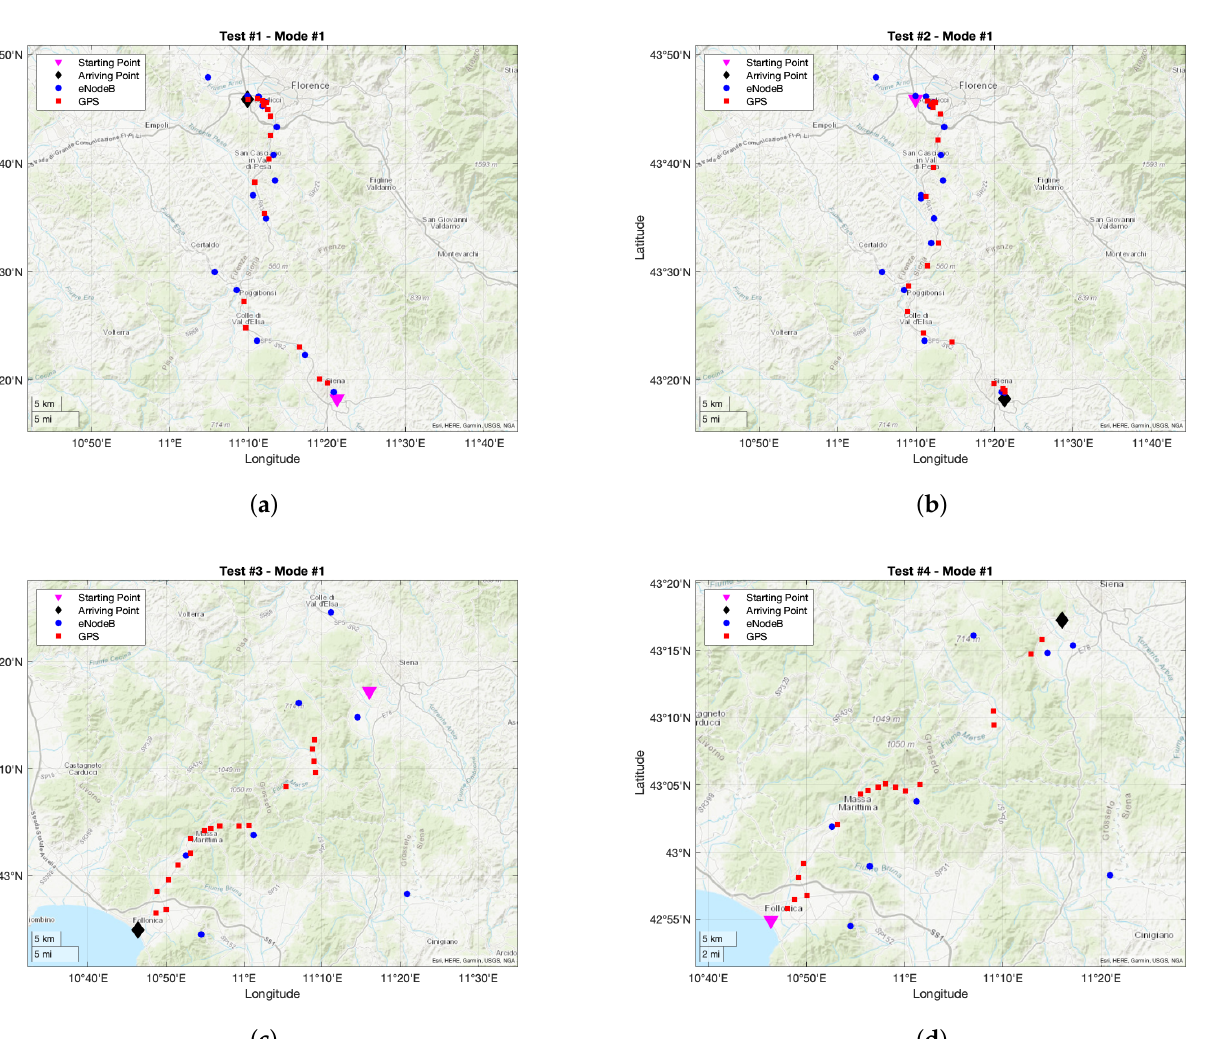
Figure 8. Tracking tests results exploiting working Mode #1: ( a ) outward trip of itinerary of Figure 6a; ( b ) return trip of itinerary of Figure 6a; ( c ) outward trip of itinerary of Figure 6b; ( d ) return trip of itinerary of Figure